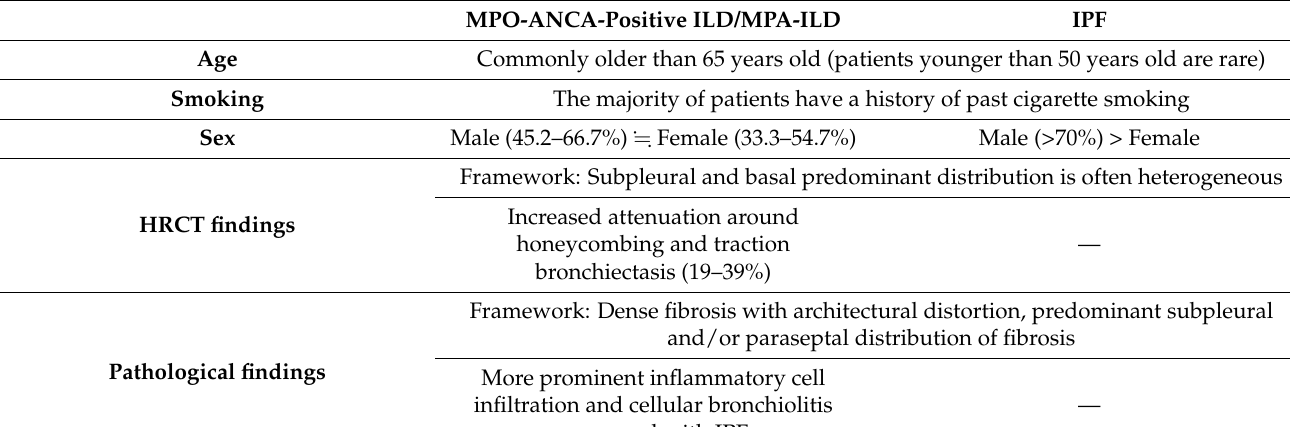
Figure 2. Transbronchial lung cryobiopsy in a case of MPO-ANCA-positive ILD. ( A ) Hematoxylin and eosin staining shows that the lesion is characterized by peribronchial dense fibrosis of alveoli with architectural destruction as a framework of usual interstitial pneumonia (UIP) pattern along with inflammatory cells in the interstitial tissue (×1) (Br, bronchus). ( B ) Elastica van Gieson staining shows partial loss of elastic lamina of a bronchiole as bronchiolitis and cystic air spaces filled with mucus (arrow) (×1). ( C , D ) A high-power magnification view of the closed square in ( A ) shows dilated bronchioles with subepithelial fibroblastic foci (arrows) and moderate infiltration of lymphocytes and plasma cells in the fibrosis ( C : ×2.5; Alcian blue staining, D : ×2.5; hematoxylin and eosin staining). ( E ) A magnified view of the dashed square in ( A ) shows a dilated bronchiole revealing shedding of epithelial cells, subepithelial fibrosis, and infiltration of lymphocytes and plasma cells, which defines bronchiolitis (×2.5; hematoxylin and eosin staining).